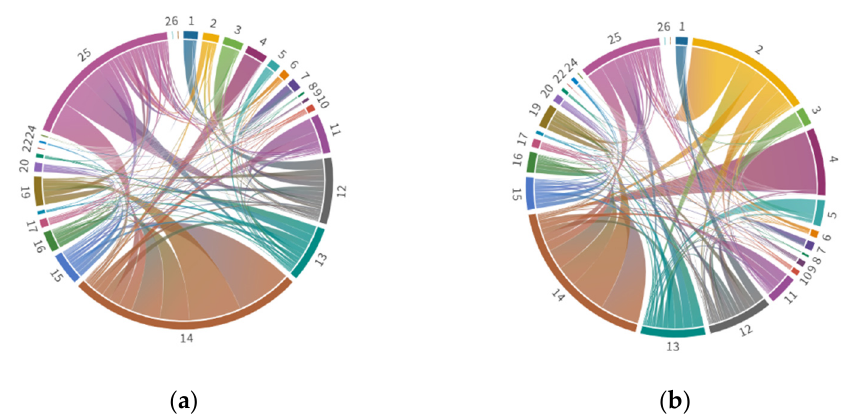
Figure 4. Flow structure of embodied pollutants between industrial sectors. ( a ) NO x ; ( b ) PM.